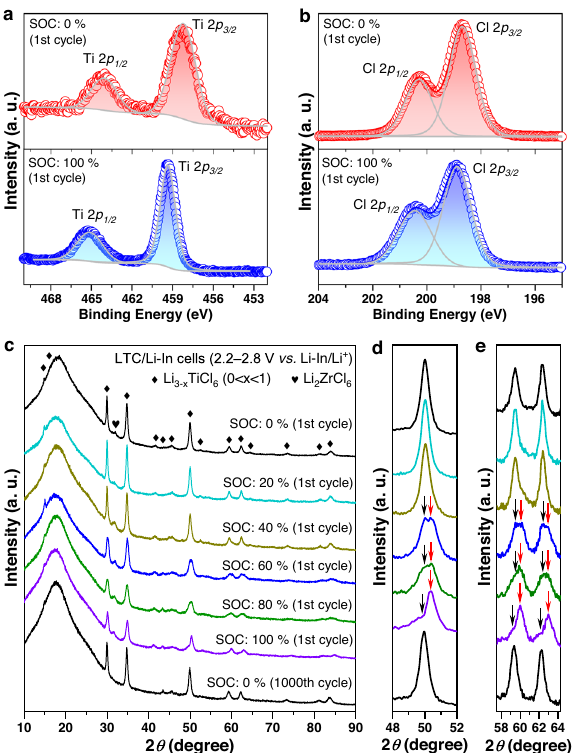
Fig. 7 | Li-ion storage mechanism of the LTC positive electrode based on the Ti 3+ /Ti 4+ redox couple. a , b Ex situ Ti-2 p ( a ) and Cl-2 p ( b ) X-ray photoelectron spectraofthe LTCpositive electrodein the Li-In | LPSCl | LZC|LTC cell atdifferent SOCs of its initial charge(the corresponding voltage pro fi lewith SOCs indicated is displayed in Supplementary Fig. 9). c Ex situ XRD patterns of the LTC positive electrode from the Li-In | LPSCl | LZC|LTC cells at different SOCs. d , e Close-up viewsoftheXRDpatternsin c .ThedataforeachSOCisplottedinthesamecoloras that in c . In the XRD patterns for 60 − 100% SOCs of the 1st cycle, the peaks of the original phase and those from the new phase are arrowed in black and red,